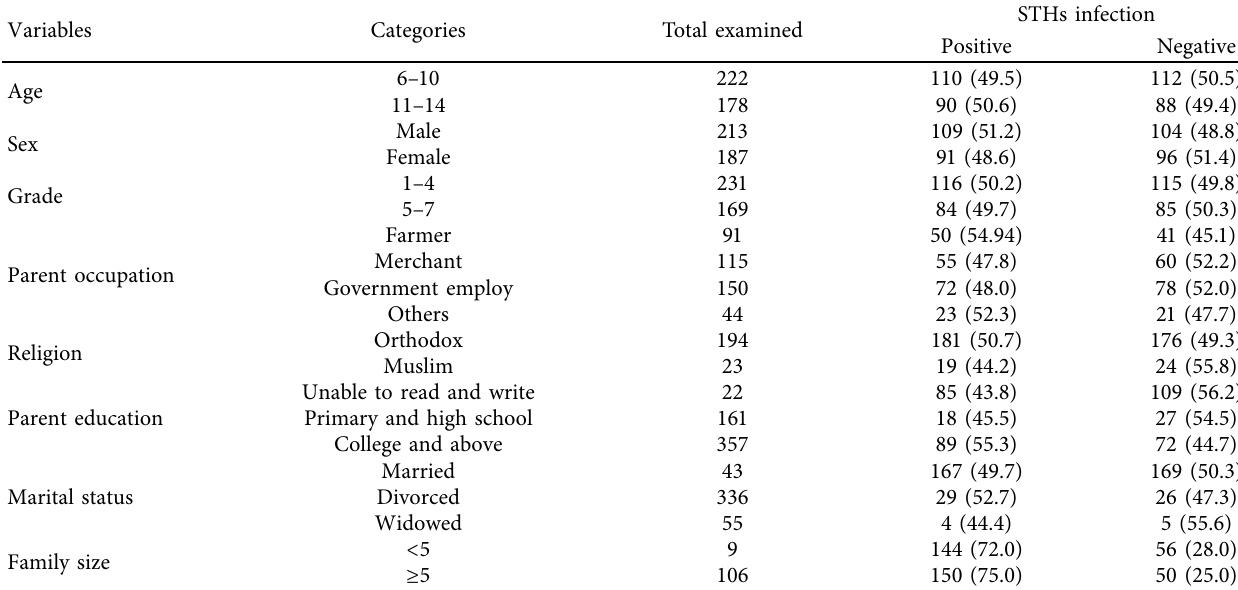
Table 2: Prevalence of STHs across various demographic variables among school children ( n � 400) at Kola Diba primary school, Northwest